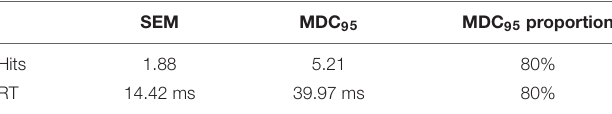
TABLE 5 | Statistics of SEM and MDC 95 for both number of hits and RT data from Study